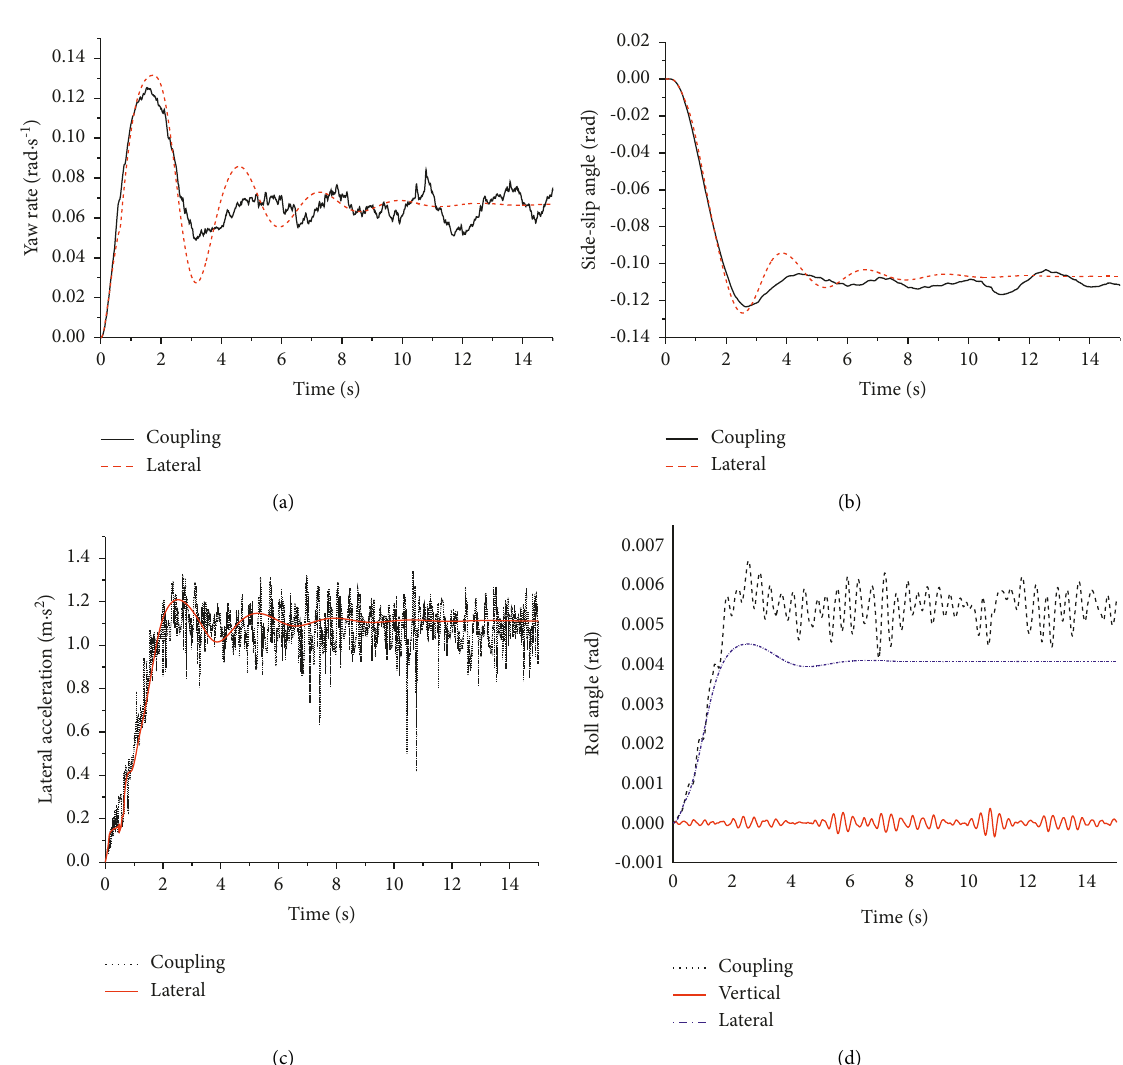
Figure 8: Handling stability (serpentine working condition, B-level random road). (a) Yaw rate. (b) Side-slip angle. (c) Lateral acceleration. (d) Roll